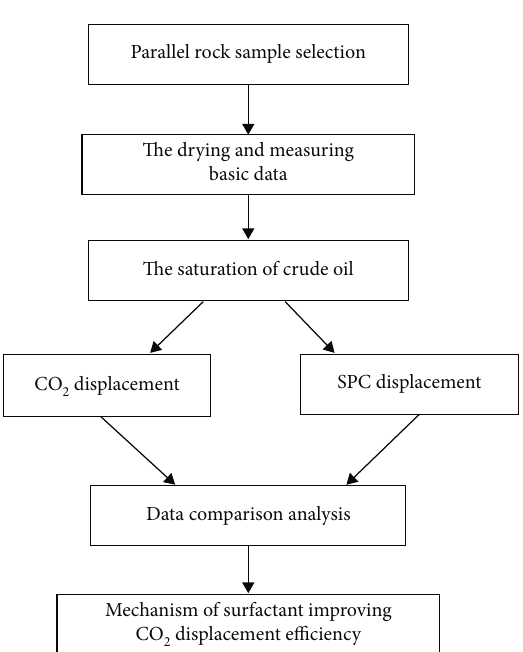
Figure 1: Experimental connection device.